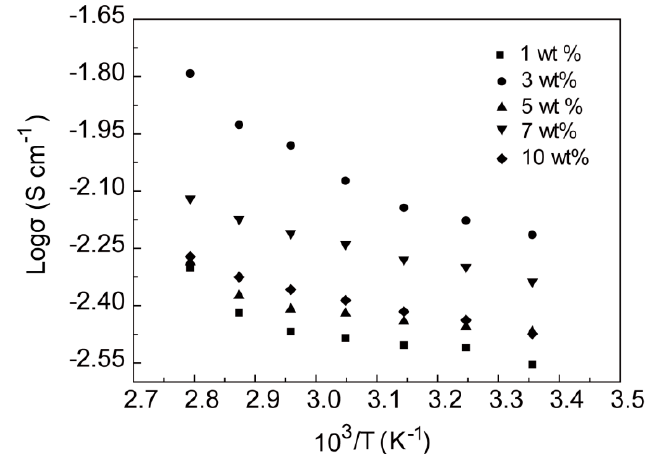
Figure 7. The variation of ionic conductivity with temperature of the GPEs with different contents of nano-MgO.